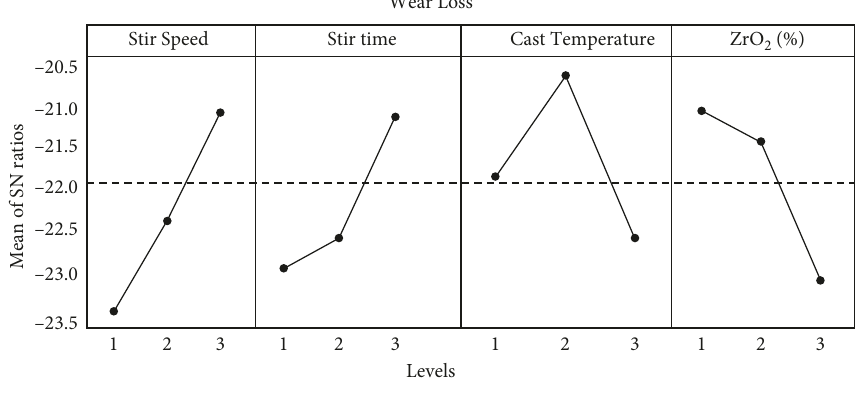
Figure 3: Main effect plot for wear loss.